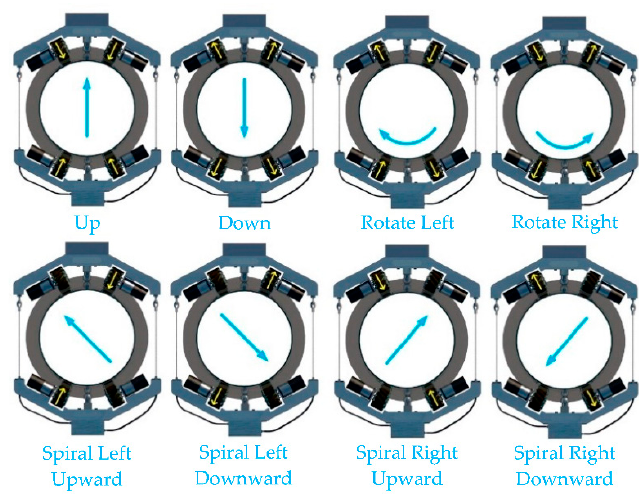
Figure 6. Climbing robot wheel movement states. Table 3. Assumed Velocities and